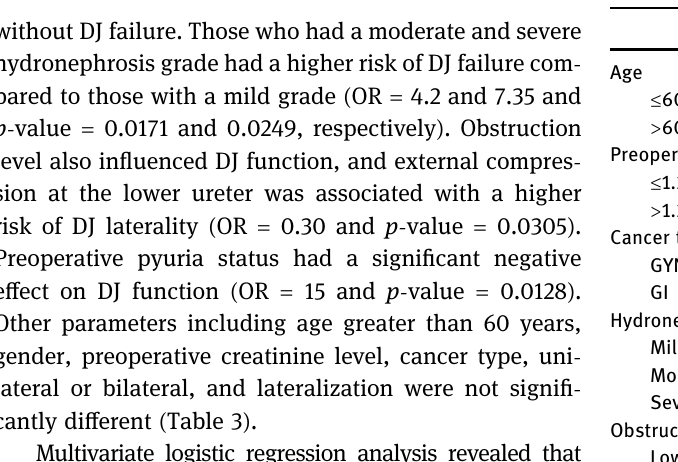
Table 4: Multivariate analysis of DJ